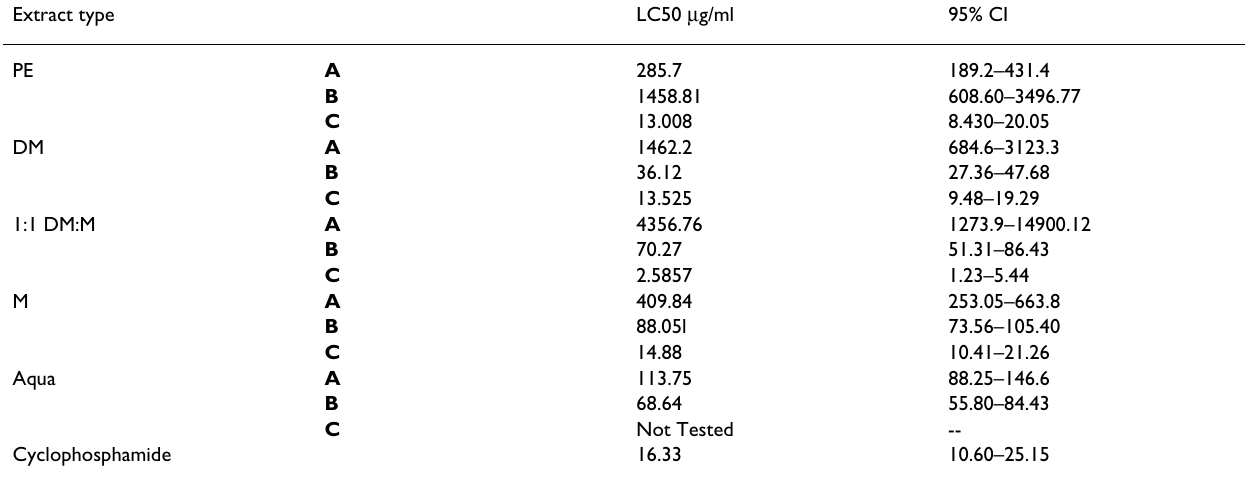
Table 4: Brine shrimp lethality tests of Terminalia brownii extracts of root (A), stem bark (B), and stem wood (C). Extract